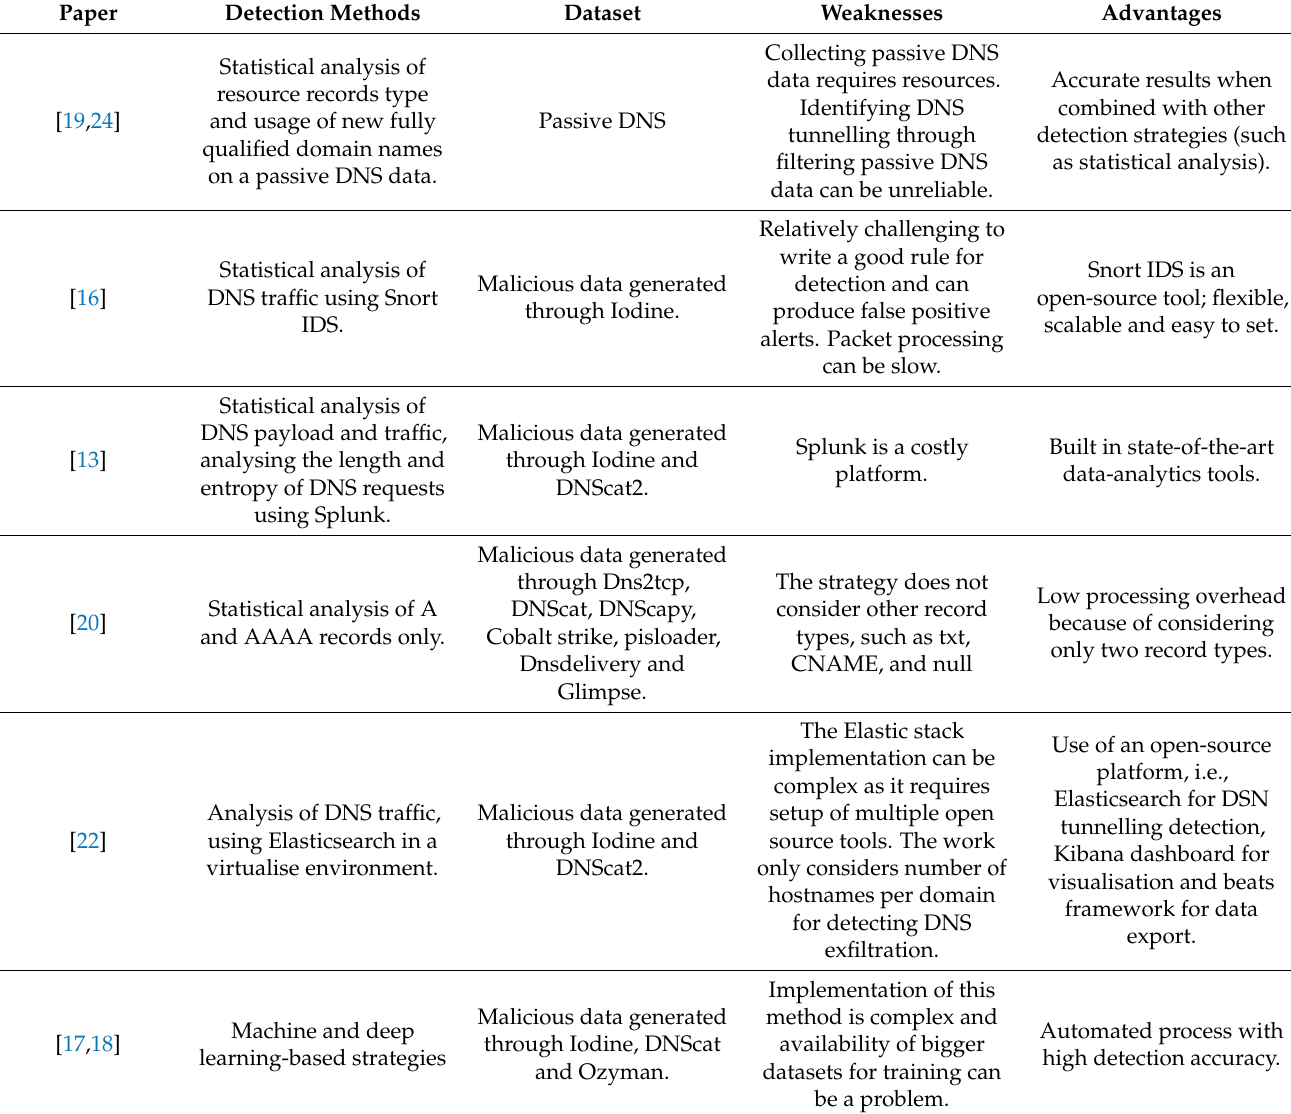
Table 1. Summary of the relevant studies for DNS tunnelling detection methods in the non-cloud